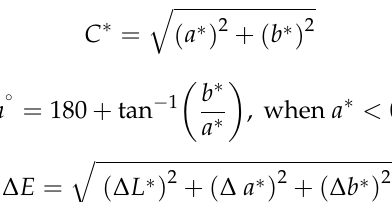
Table 5. Microbial load of noni juice under refrigerated (4 ◦ C) storage conditions. Week 0 (log CFU/mL) Sample